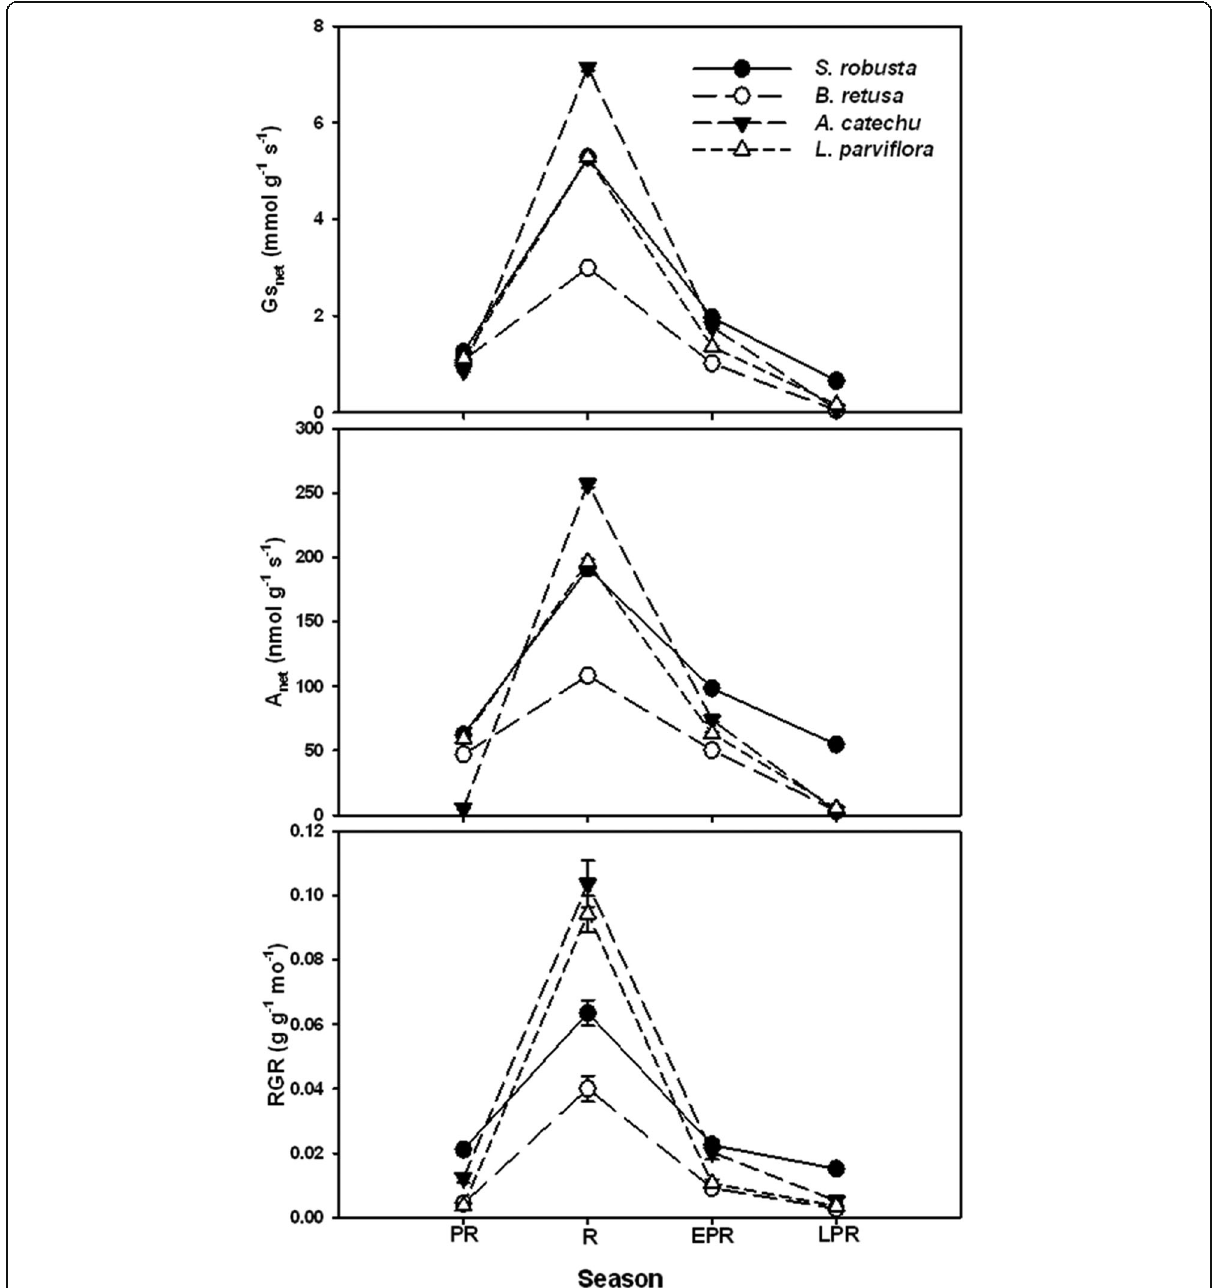
Fig. 4 Seasonal variations in leaf attributes and relative growth rates (RGR) in four dry tropical tree species across four sites. Gs net , net stomatal conductance; A net , net photosynthetic rate; PR, pre-rainy; R, rainy; EPR, early post-rainy; LPR, late